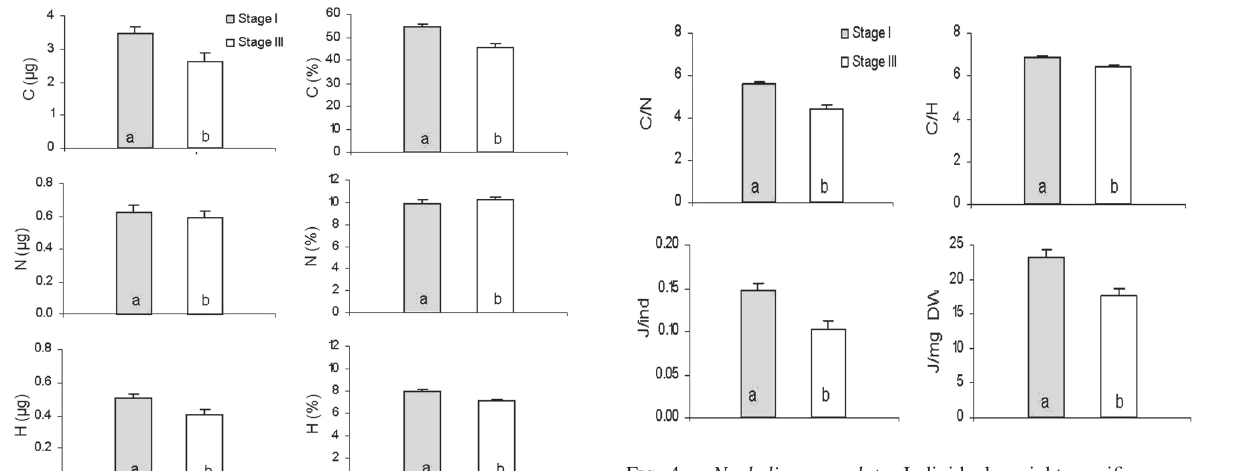
Fig . 4. – Neohelice granulata. individual, weight-specific energy contents (J/ind, J/mg dW), C/n and C/H ratio of eggs (mean ± Sd); beginning vs end of embryonic development (i vs iii); data Fig . 3. – Neohelice granulata. Embryonic contents of carbon (C), from mudflats and salt marshes pooled; different letters indicate nitrogen (n), hydrogen (H) (in µg/individual, % of dW; mean ± significant differences (see Tables 6 and 7 for anoVa). Sd); beginning vs end of embryonic development (stages i vs iii); data from mudflats and salt marshes pooled; different letters indicate significant differences (see Tables 6 and 7 for anoVa). Table 6. – Neohelice granulata . Two-way anoVa evaluating differences in embryonic carbon (C), nitrogen (n), hydrogen (H), energy content, C/n and C/H ratios, comparing different developmental stages (i, iii) and habitats (mudflats vs saltmarshes). Symbols as in Table 4. Variable